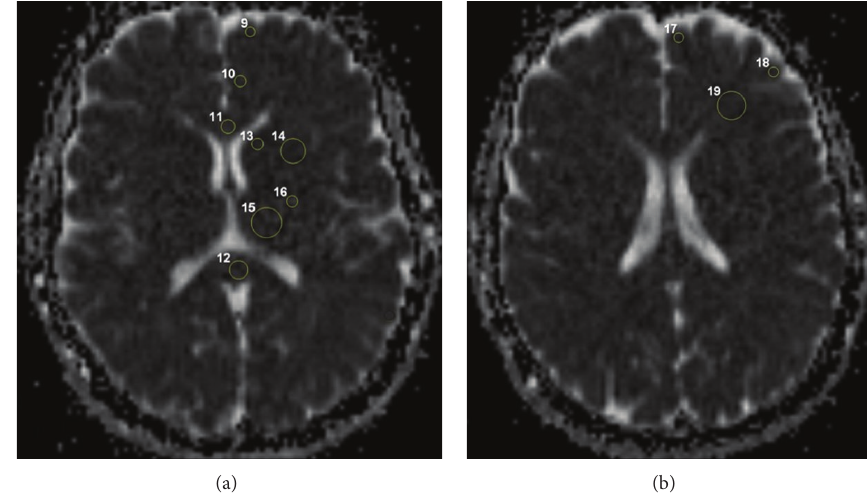
Figure 2: ADC maps showseveral ROIs:orbitofrontal cortex (9), cingulate gyrus (10),genu (11)and splenium (12) of corpus callosum, caudate nucleus (13), putamen (14), thalamus (15), and posterior limb of internal capsula (16) on (a); dorsomedial (17) and dorsolateral (18) frontal cortices and frontal white matter (19) on